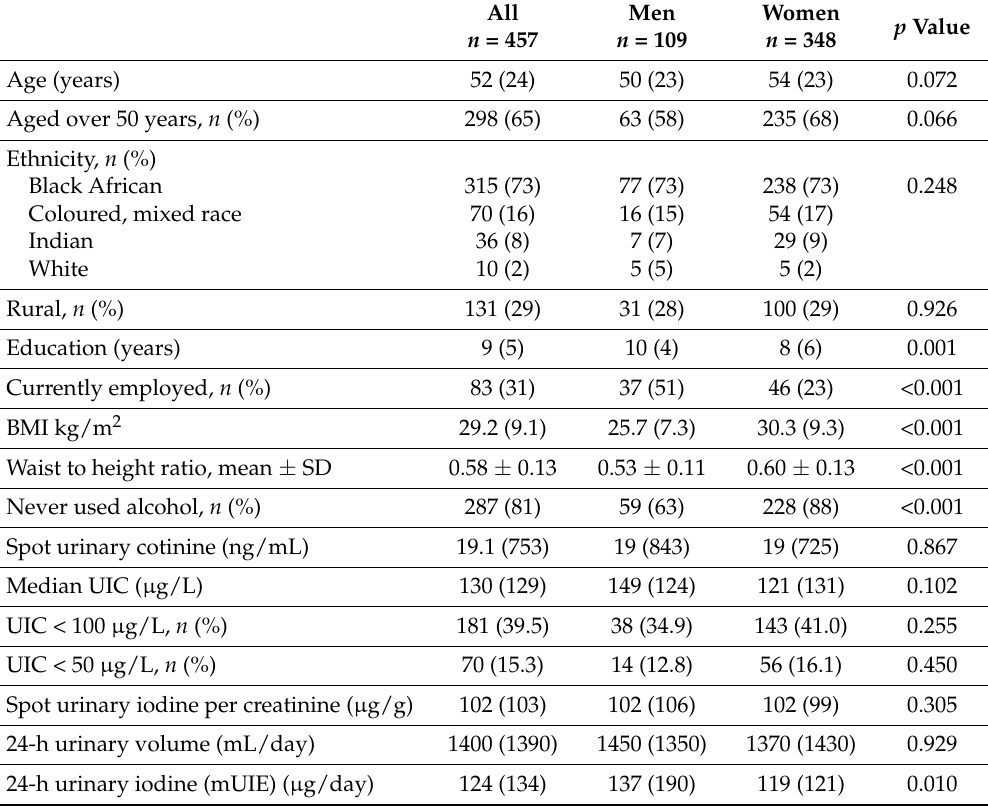
Table 2. Characteristics of the study cohort by sex, WHO Study on global AGEing and adult health (SAGE) South Africa Wave 2